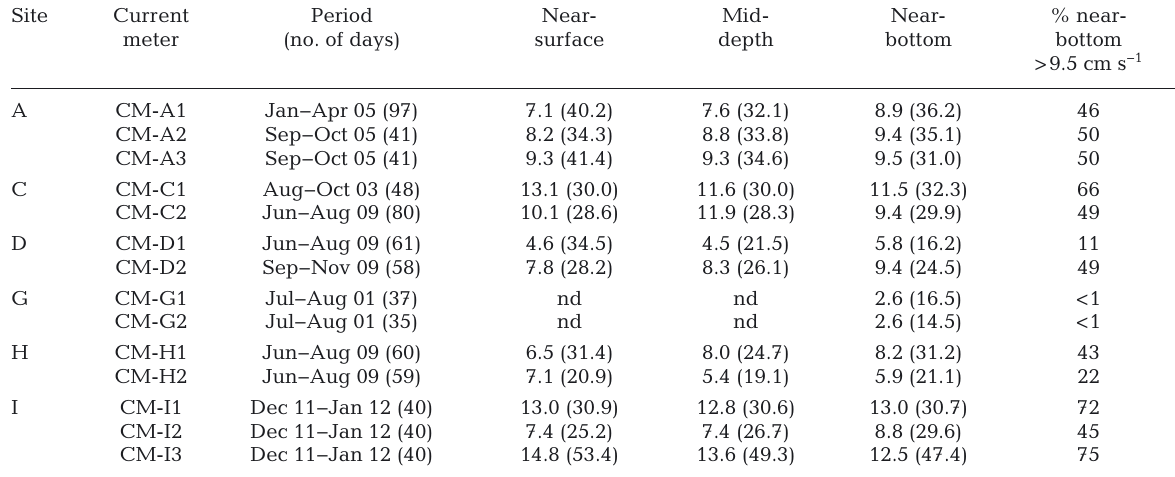
Table 5. Current speeds and percentages of near bottom records >9.5 cm s −1 for hourly records from current meter (CM) deployments at 6 study sites (see Fig. 3 for locations). Current speed values are medians, with maxima in parentheses. At Site G, current velocities were measured at only 1 depth, 6 m above the seafloor. nd: not